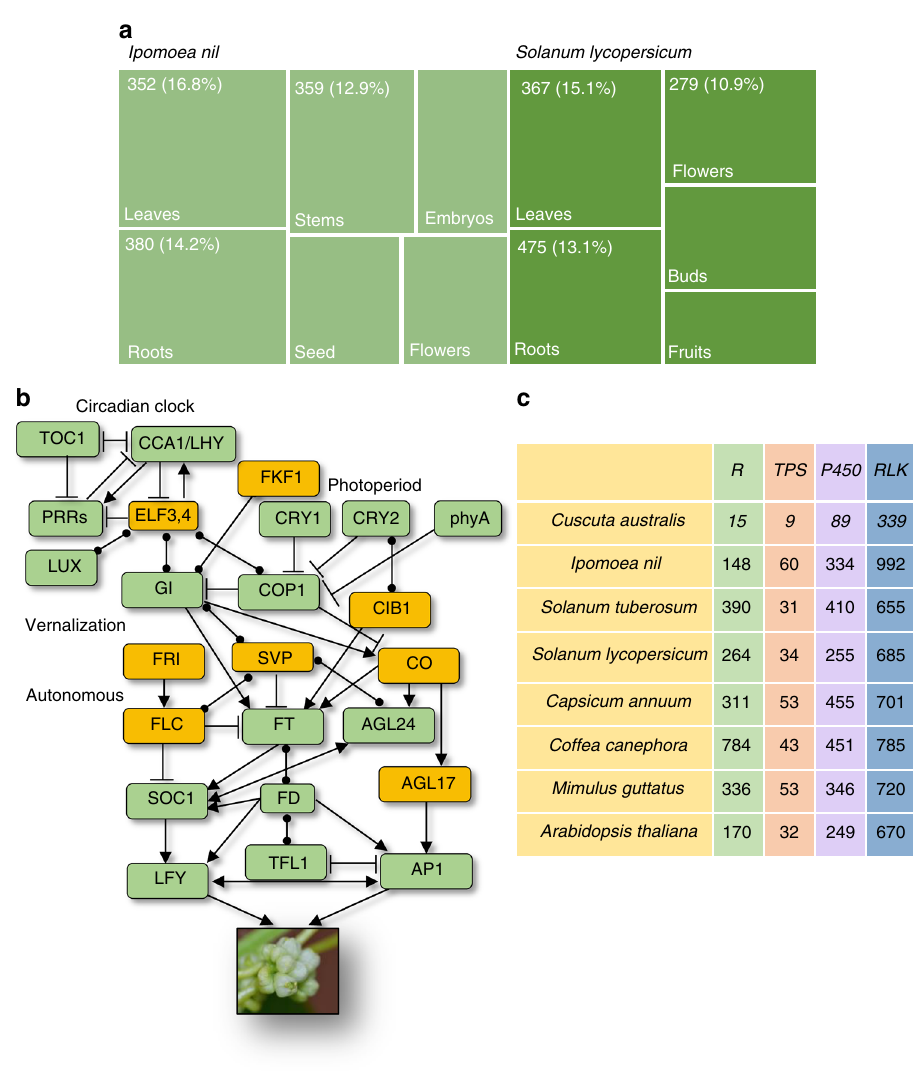
Fig. 3 Gene losses in C. australis . a The principally expressed tissues (PETs) of the respective orthologs of C. australis lost genes in S. lycopersicum and I. nil . The boxes represent different tissues. The respective PETs of the orthogroups, which have no C. australis members, were identi fi ed in S. lycopersicum and I. nil . The numbers of orthogroups, which have PETs in leaves, roots, fl owers, and other tissues, are shown in the boxes, and the respective percentages (proportional to the areas of the boxes) indicate the ratios between these indicated numbers and the numbers of all orthogroups whose PETs were identi fi ed to be the corresponding tissues of I. nil and S. lycopersicum . b Simpli fi ed gene network controlling fl owering time. Genes in green boxes are retained in C. australis , and the lost ones are in orange boxes. Arrows and T-ends represent promoting and inhibiting genetic interactions, respectively, and round dots at both ends symbolize genetic interactions with unknown directions. c Numbers of genes in the gene families of R genes, TPS s, P450 s, and RLK